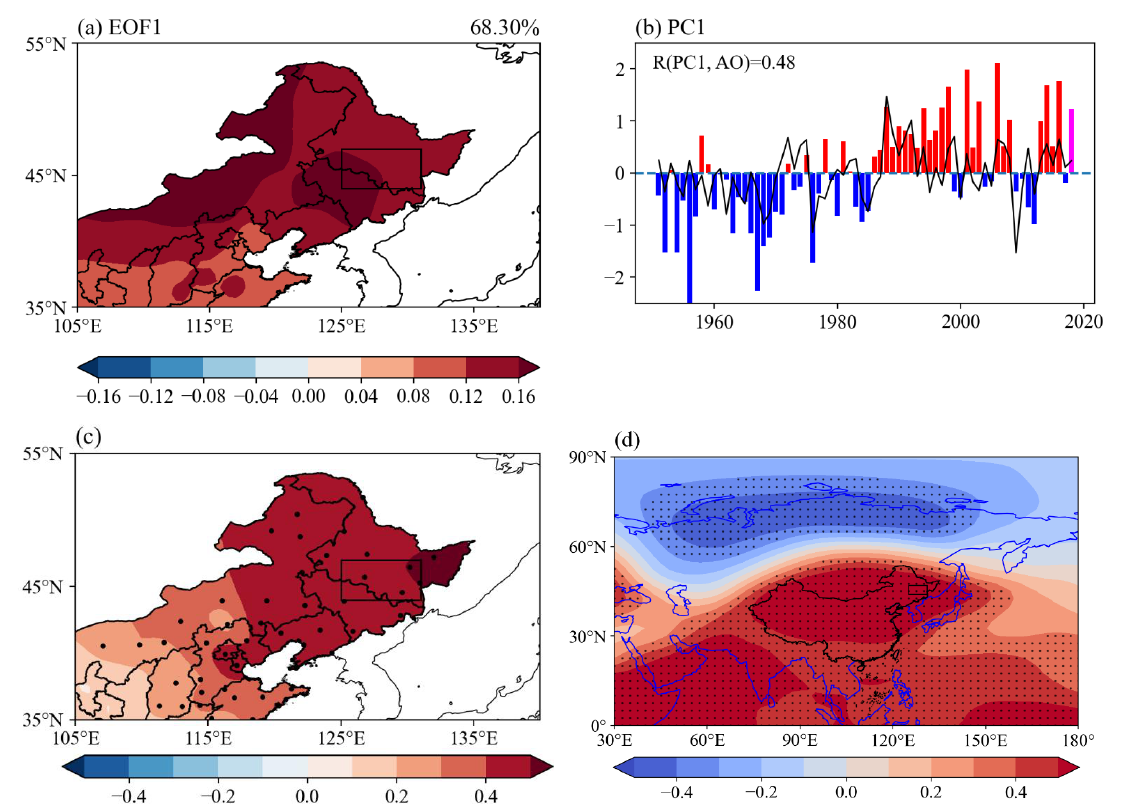
Figure 3. ( a ) The first leading mode of the EOF for air-temperature anomalies in the winter of 2018/2019 over NEC and ( b ) its related first principal component (PC1). ( c ) The distribution of the correlation coefficient between AO and winter temperature in NEC. ( d ) The regression distribution of geopotential height anomalies at 500 hPa with regard to PC1. In ( b ), the bars represent PC1 (the extreme year is highlighted by pink), and the black line is AO. In ( c , d ), the dotted regions indicate the correlation and regression coefficients are significant at the 95% confidence level. Samples used in calculations were from